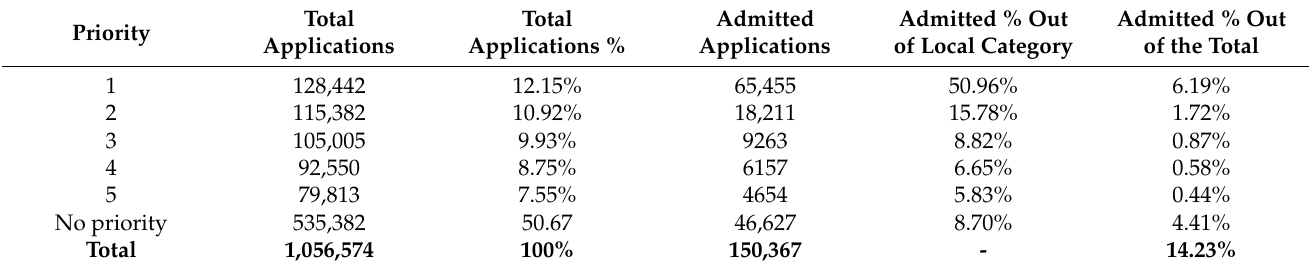
Table 3. Statistics on entrants who applied for state-funded